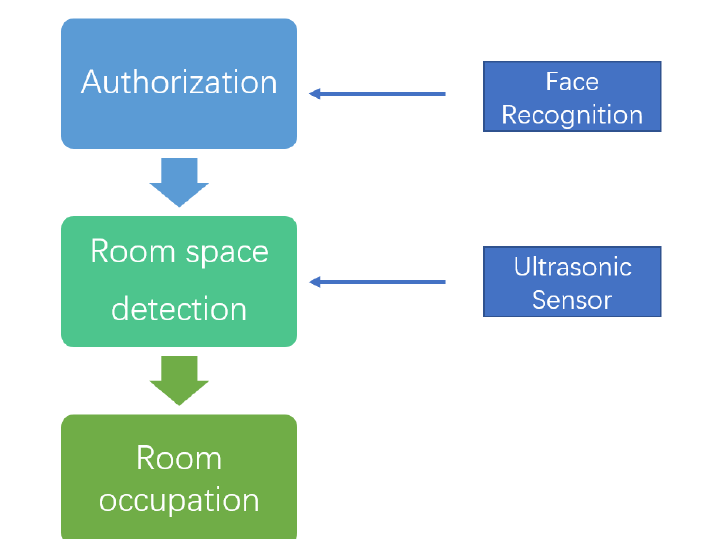
Figure 4. The block diagram for the process of study room occupancy [89].